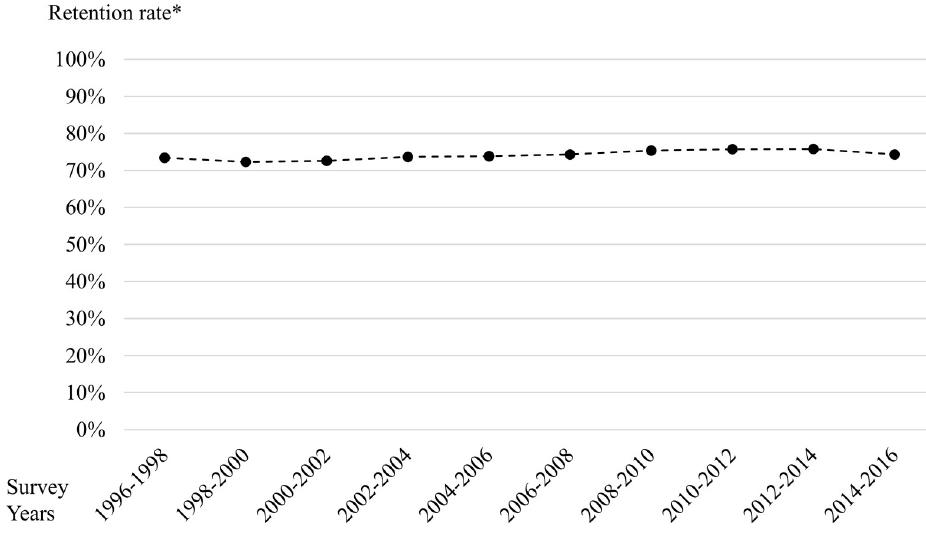
Fig 2. Temporal trend in the retention rate of physicians working at GHSFs in Japan from 1996 to 2016. � Retention rate was defined as the number of physicians working at GHSFs in the subsequent survey (e.g., in 1998) divided by the number of physicians working at GHSFs in the current survey (e.g., in 1996) among physicians responding to both surveys (e.g., in 1996 and 1998).